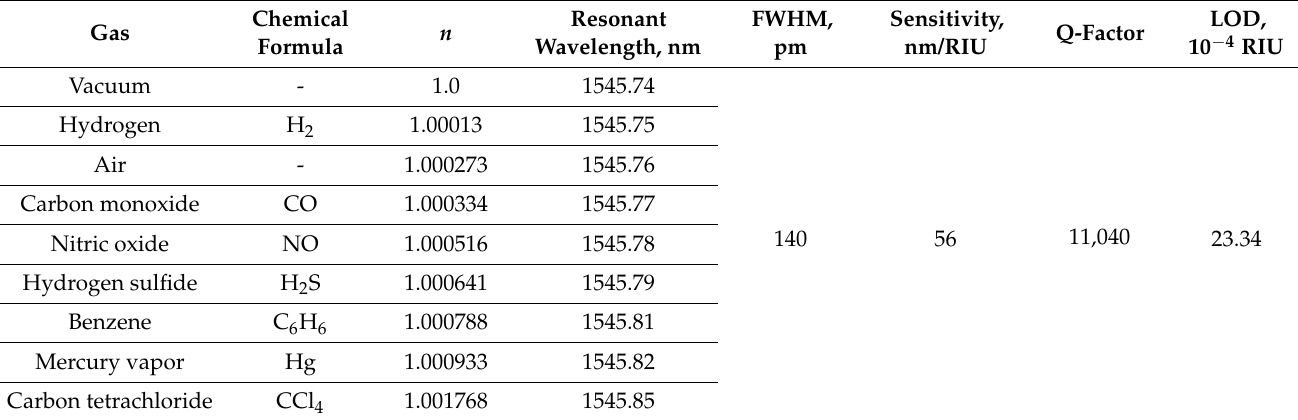
Figure 6. E-field distribution of the CCl 4 sensor at ( a ) a non-resonant wavelength (1545.03 nm) and ( b ) a resonant wavelength (1545.73 nm). Table 3. Add-drop sensor characteristics for different gases.